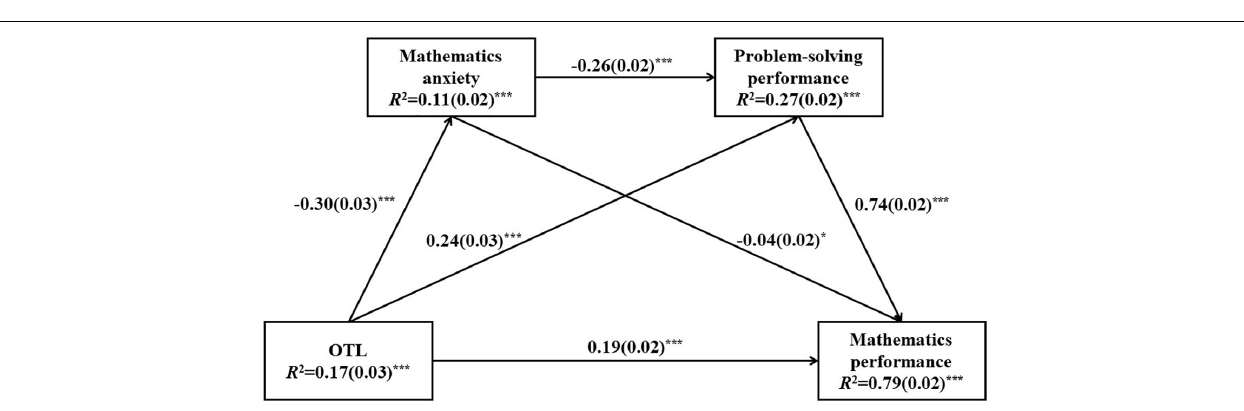
Shanghai-China, standardized estimate = 0.15, p < 0.001; in the United States, standardized estimate = 0.19, p <